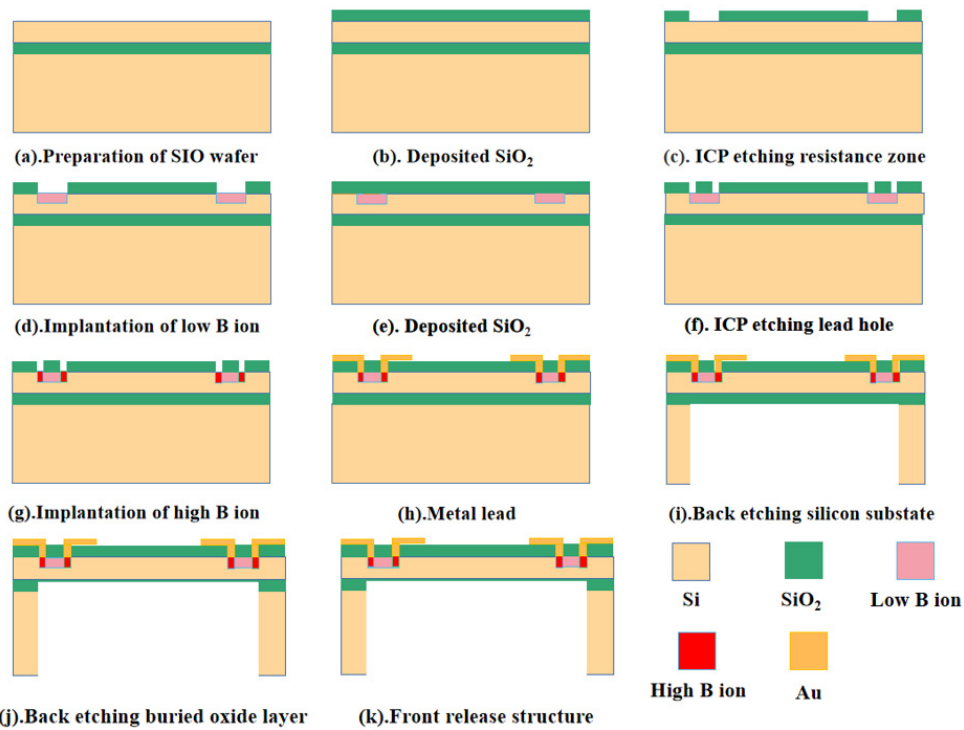
Figure 8. Schematic diagram of main process flow of sensor microstructure.